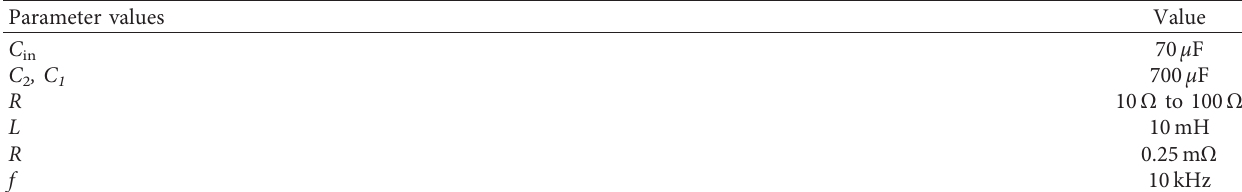
Table 4: Three-level boost converter